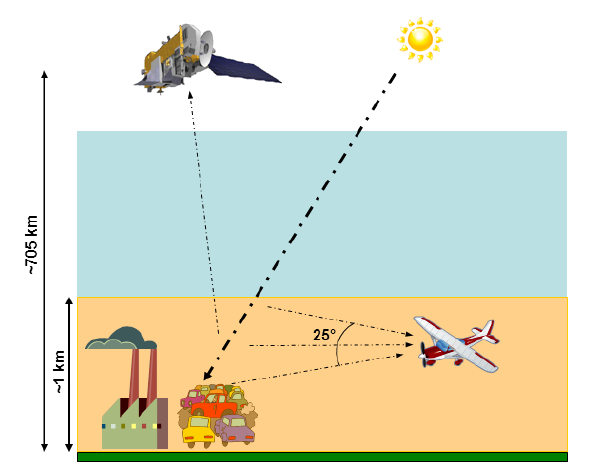
Fig. 1. Geometry of our ULM-DOAS measurements compared to a nadir-looking satellite instrument like